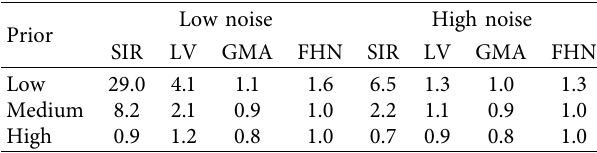
Table 4: MSE ratios for nonlinear parameters (large